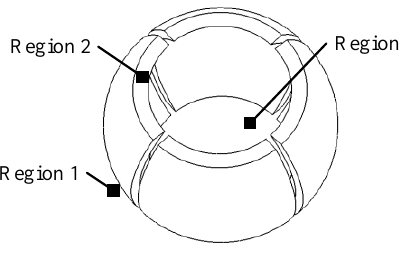
Figure 2. Region division of the permanent magnet.